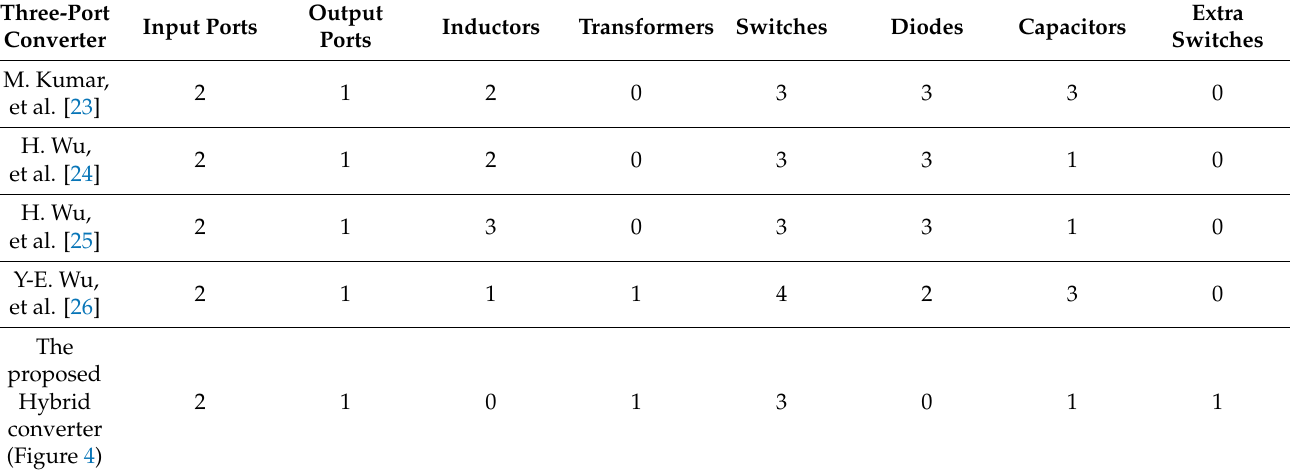
Table 1. Comparison of component counts with the proposed hybrid converter and its